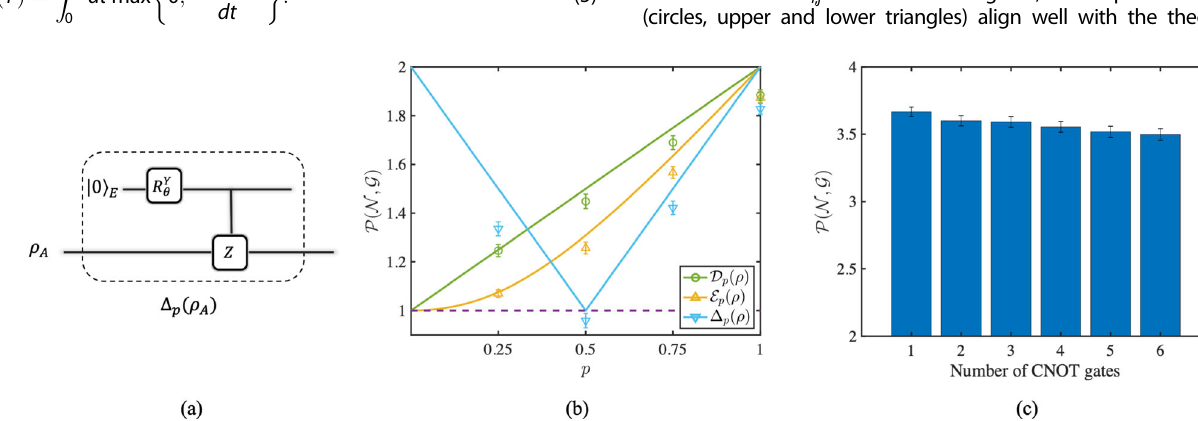
Fig. 3 Experimental veri fi cation of the benchmark with IBM Q hardware. a Circuit diagram for realising the dephasing channel. b The RQM of dephasing channels